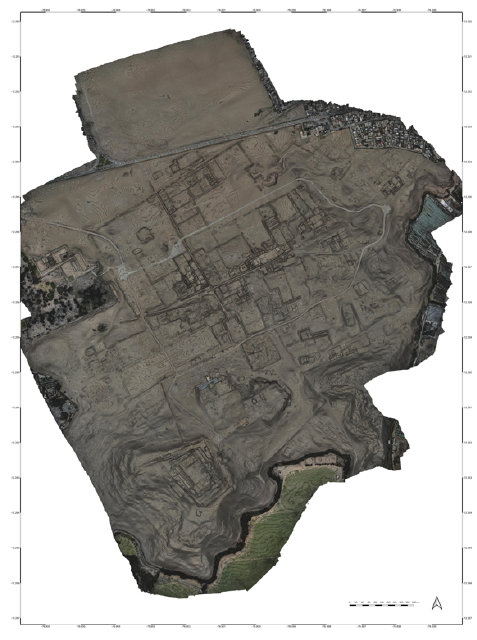
Figure 10 . Overlay of orthophoto and contour